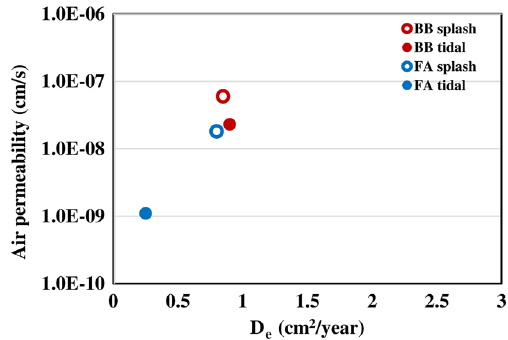
Fig. 10 Air permeability versus effective chloride diffusion coefficient (D e ) for exposed